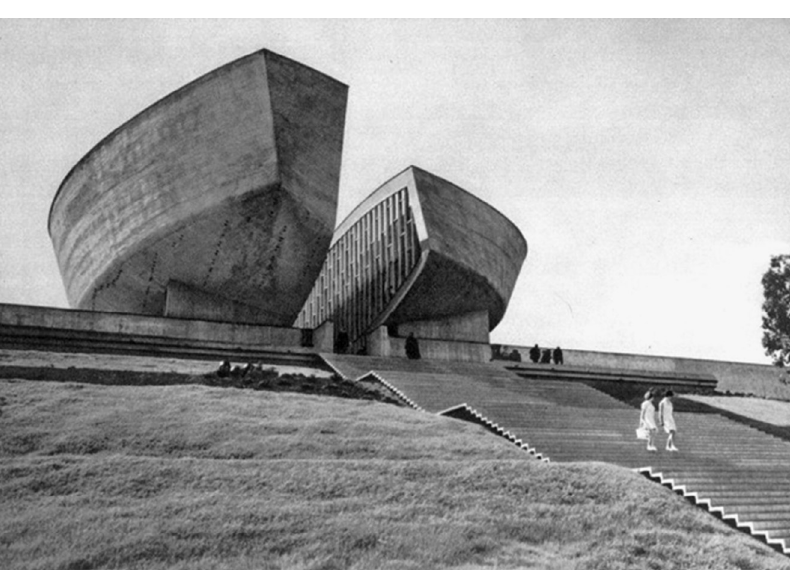
Figure 1. Museum of the Slovak National Uprising in Banská Bystrica, Photo by Karel Plicka (c. 1950). (“Four Photographs of Czech and Slovak Modernist Structures by Karel Plicka,” The Serendipity Project, December 6,